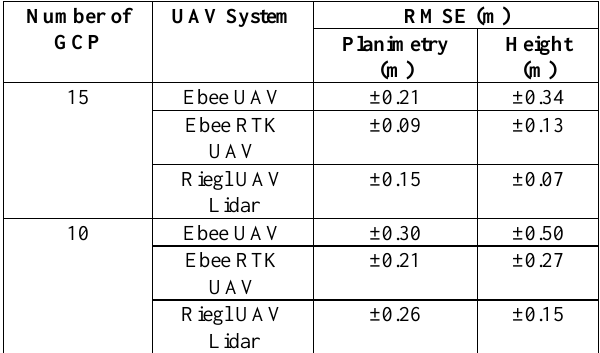
Figure 7. 3D Model (Left) and DTM (Right) from Riegl UAV Table 2: Accuracy assessment of UAV system in Lidar